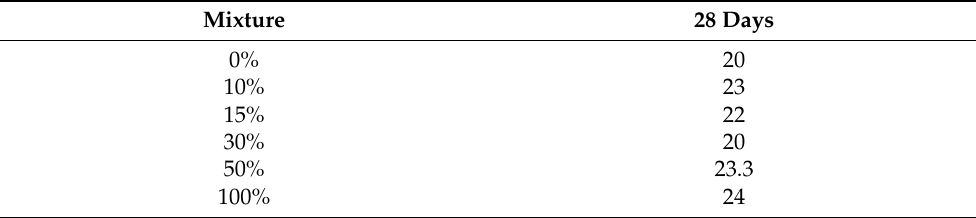
Figure 16. Representative stress-strain data from video extensometer for 15% glass substation, indicating modulus of elasticity (MoE) to be 22.3 GPa. Table 2. Values of MoE in